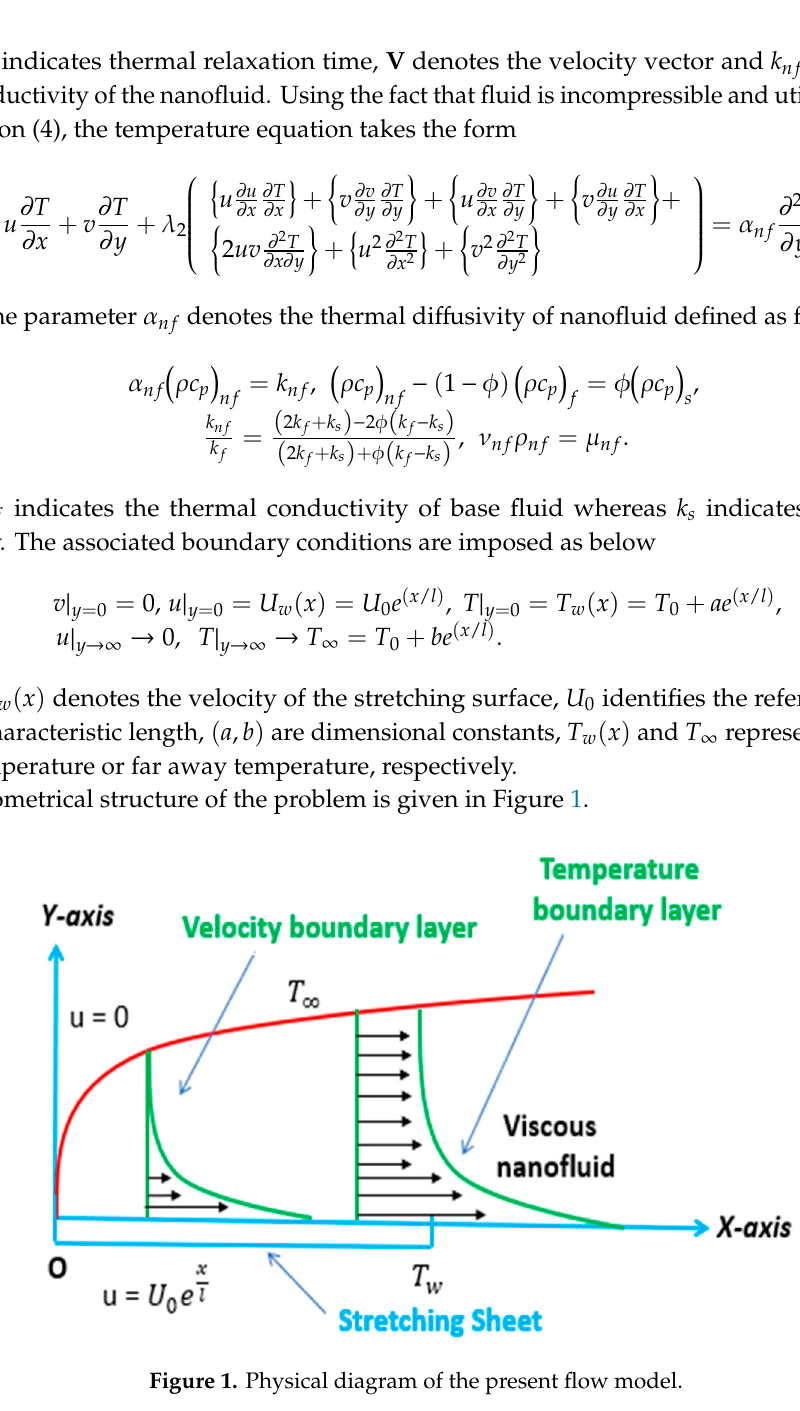
Figure 1. Physical diagram of the present flow model.